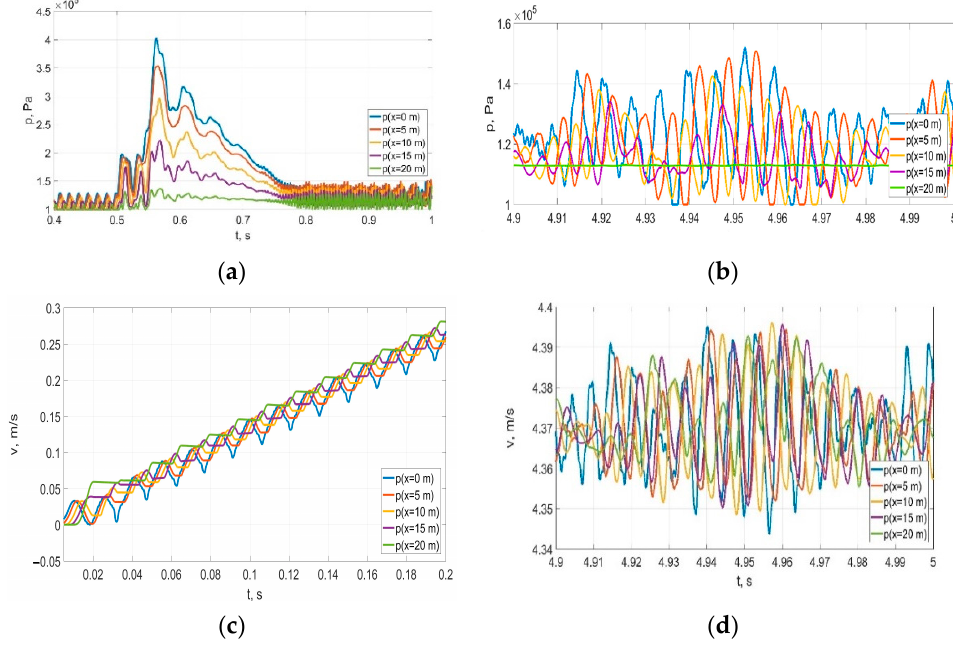
Figure 15. Pressure in the 6th pipe (L6) (Table 2) of the LNG transportation system: Note: ( a ) Pressure observation when the system starts working; ( b ) Pressure observation at the end of the solution time; ( c ) Velocity observation when the system starts working; ( d ) Velocity observation at the end of the solution time.